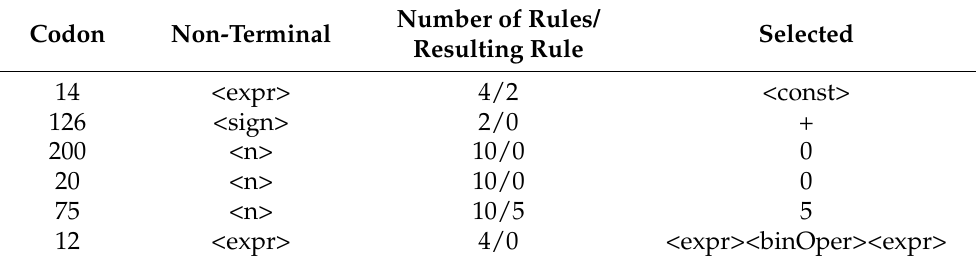
Table 4. Using the chromosome { 14,126,200,20,75,12,215,178,48, 88,78,240,137,160,190,98,247,11 } to create Equation